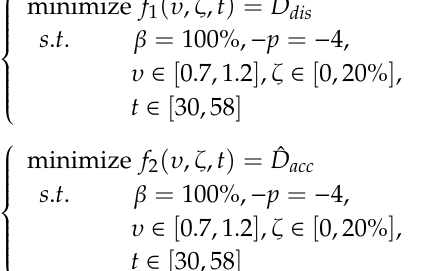
space are displayed in Figure 9: